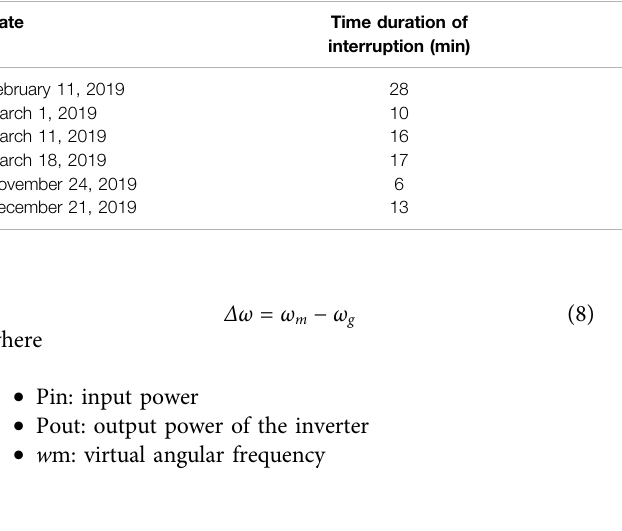
TABLE 2 | UFLS instances occurred in the selected